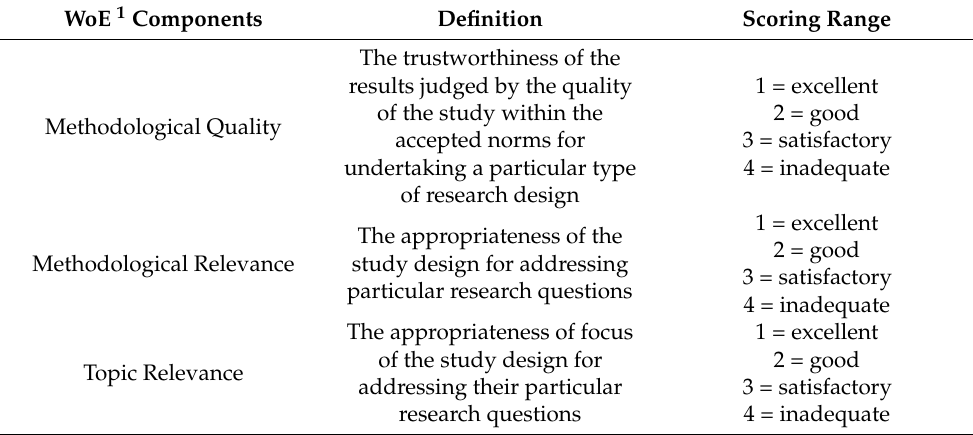
Table 2. Components of the EPPI-Centre weight of evidence